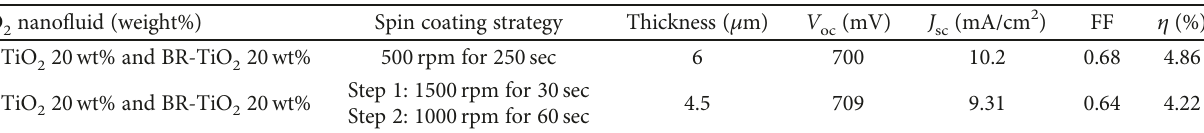
Table 2: Photovoltaic performance of DSSCs using water-based TiO manufacture the semiconductor on FTO substrate.